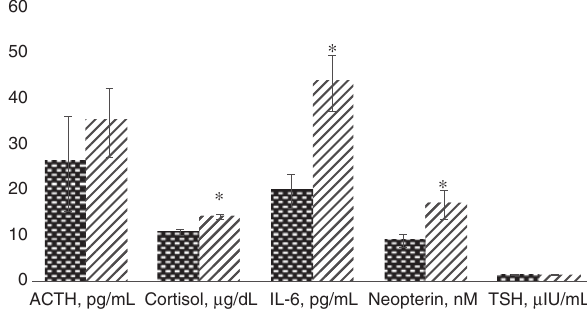
Figure 1: Alterations of ACTH-independent cortisol production associated with IL-6 and neopterin values. * p < 0.05, control vs. cancer